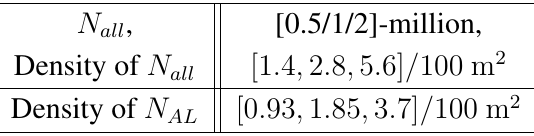
Table 6. Parameters of sensor